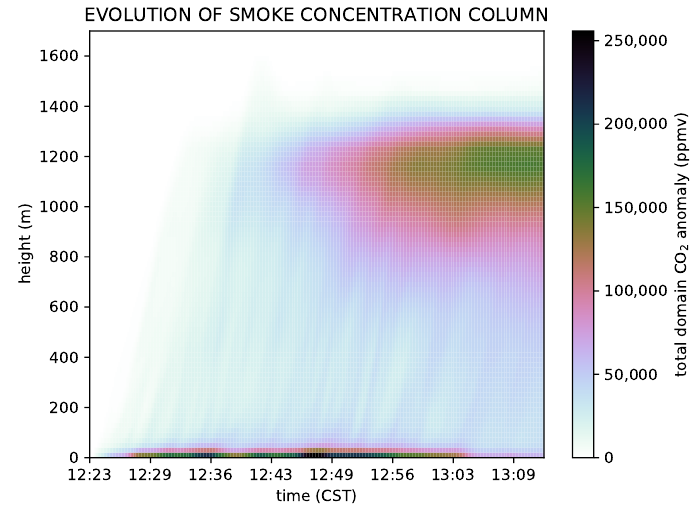
Figure 7. Evolution of total column CO 2